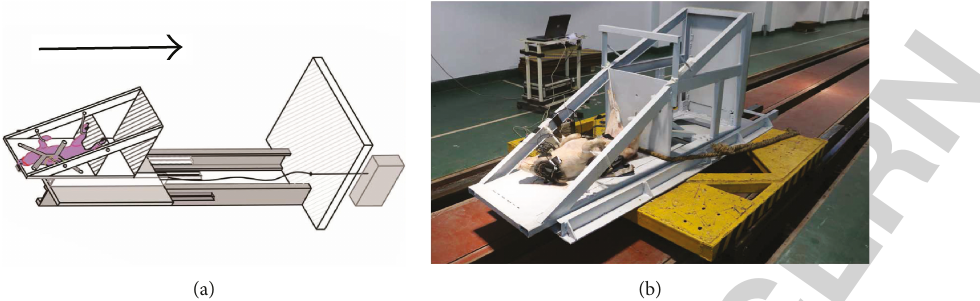
Figure 1: The schematic diagram and photograph of the installation. (a) Schematic diagram. The setup comprises a sled with three thin steel pipes, a horizontal seat assembly fi xed on the carriage, rail, rigid wall, and traction control system. When the thin steel pipes collide with the rigid wall, the sled stops and the carriage continues to move forward and impact with the rigid wall, and fi nally the buttock of the pig experienced a high caudocephalad acceleration loaded from the seat. (b) The setup photograph. The pig lays in a supine position on the carriage, and the setup was ready for the